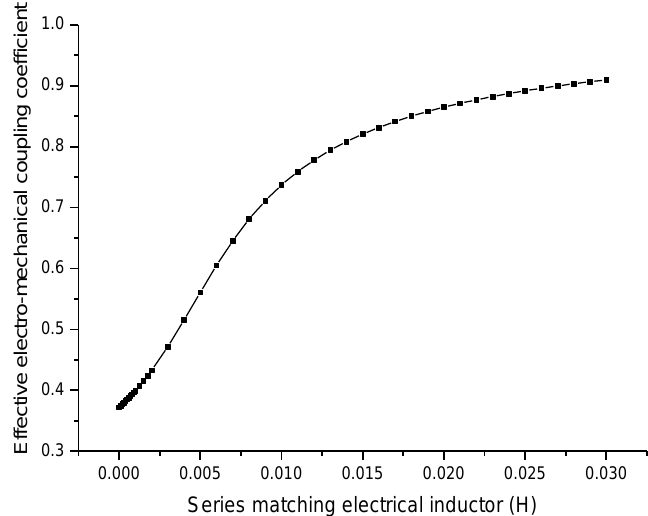
Figure 9. Dependency of the effective electromechanical coupling coefficient on the series matching inductor.